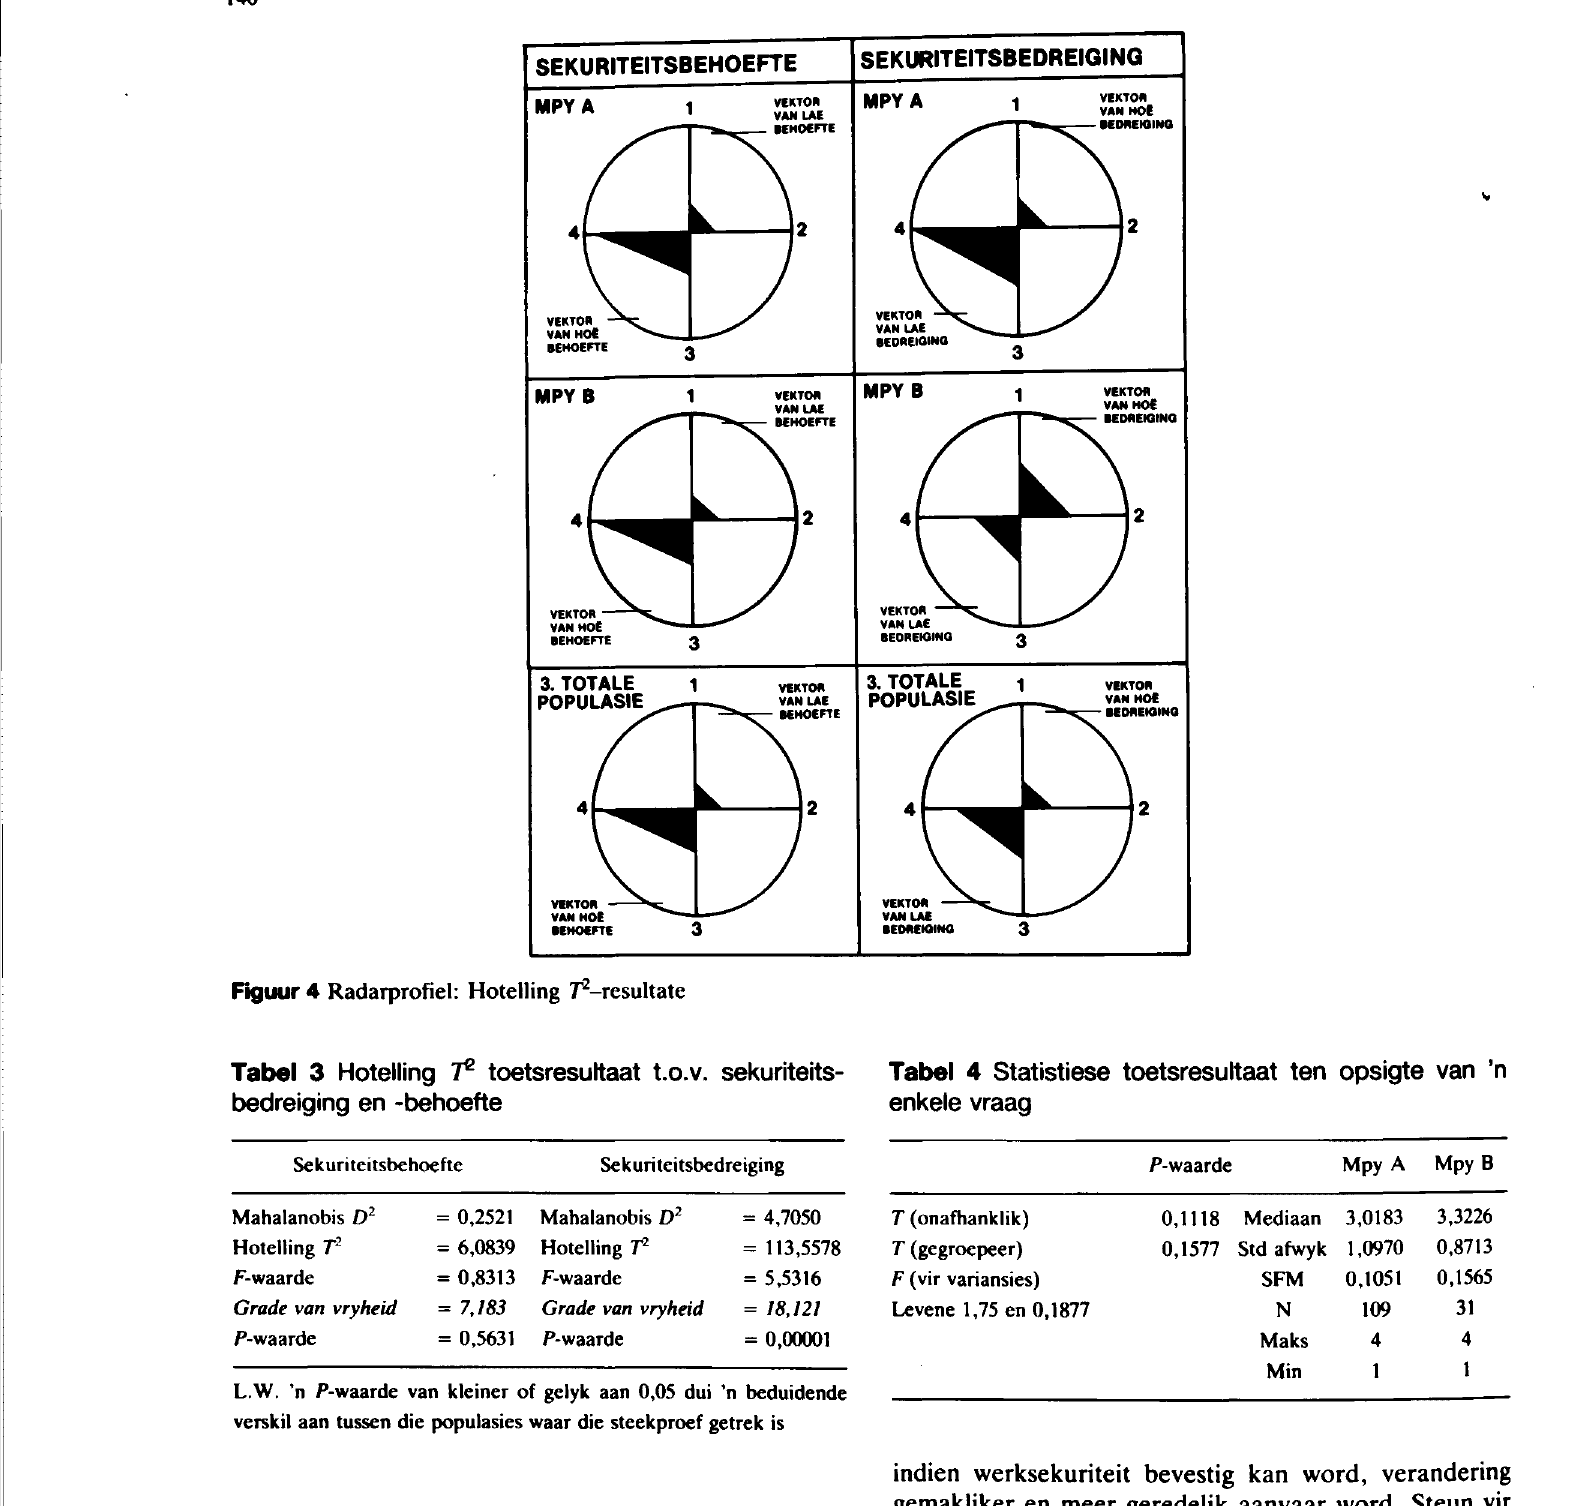
bedreiging en -behoefte